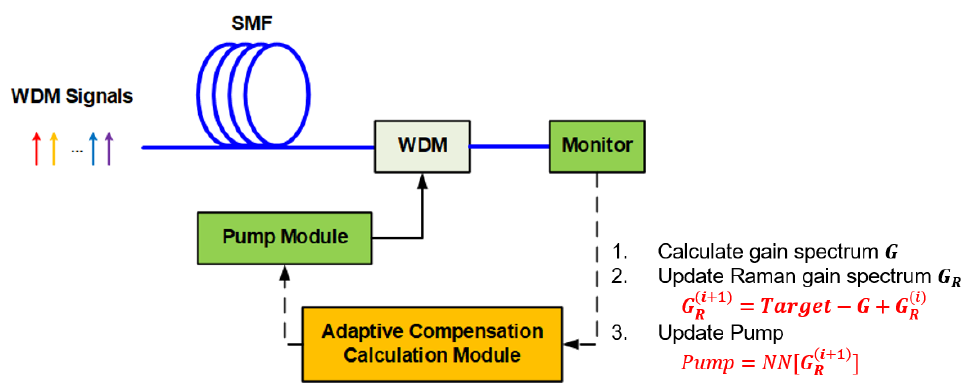
Figure 10. The realization of dynamic compensation with Raman arbitrary gain spectrum utilizing DRA based on broadband